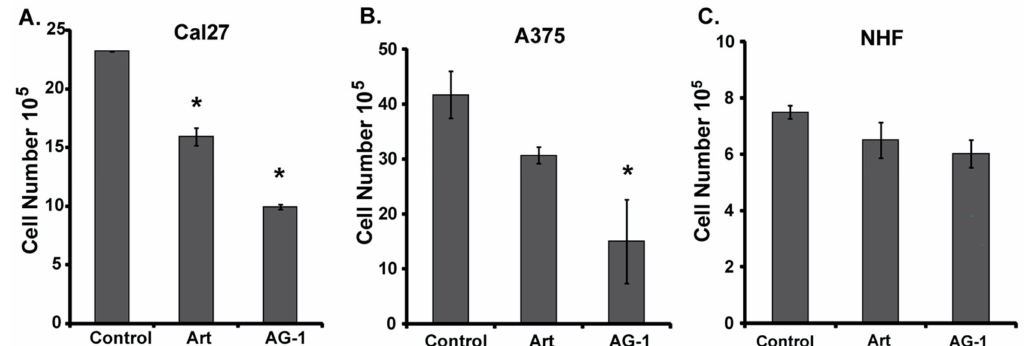
Figure 3. Artemisinin dimer (AG-1) treatments di ff erentially inhibit proliferation of cancer vs. normal cells. Monolayer cultures of ( A ) Cal27 human head–neck cancer cells, ( B ) A375 human melanoma cells and ( C ) normal human fibroblasts (NHFs) were treated with 100 µ M of Art and AG-1. Cell numbers were counted at 48–96 hours post-treatment. Asterisks represent significance compared to cell numbers in untreated control cells, n = 3, p <